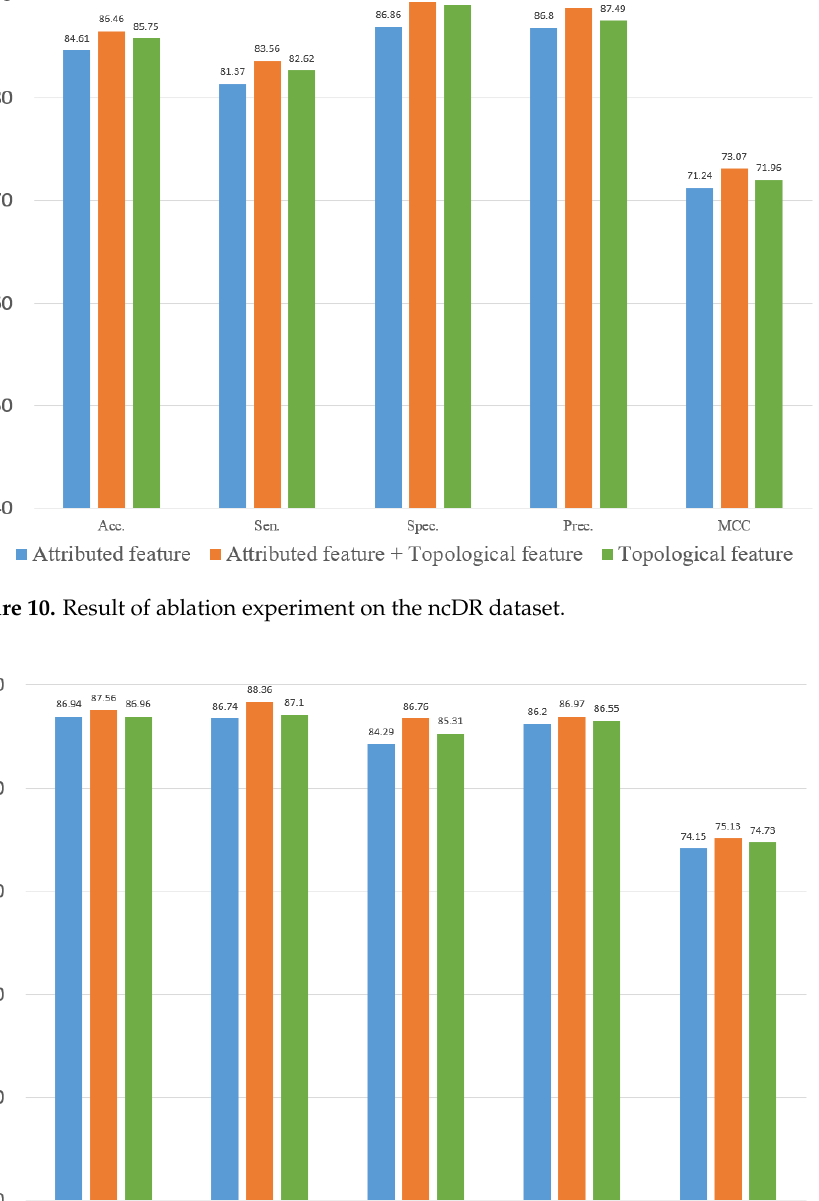
Figure 9. ( a )The ROC curves of the result generated by different classifiers using the SM2miR da- taset. ( b ) The PR curves of the result generated by different classifiers using the SM2miR dataset.